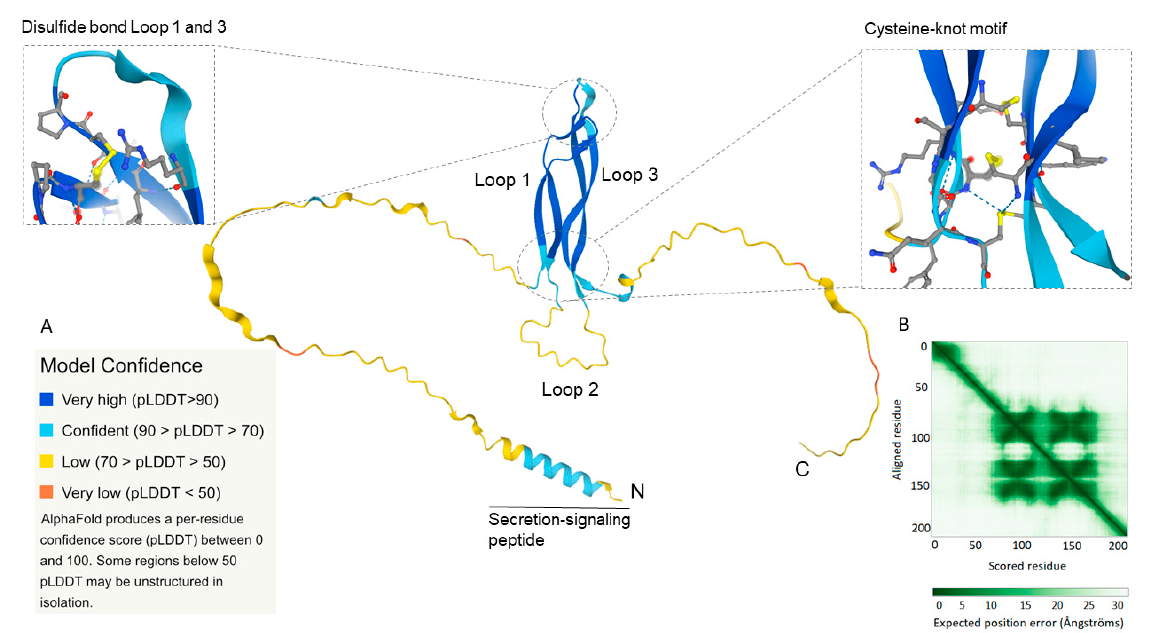
Figure 4. The three-dimensional structure of human sclerostin was generated from the amino acid sequence in the novel AlphaFold Protein Structure Database (https://alphafold.ebi.ac.uk/entry/Q9BQB4) (accessed on 19 September 2021) [58]. The protein comprises a core structure of loops 1 and 3, each having two anti-parallel running β -sheets linking with three disulfide bonds (cysteine- knot motif, magnification to the right; disulfide bond in yellow) and one disulfide bond in the top (magnification to the left; disulfide bond in yellow). Sclerostin contains also a flexible second loop in the bases and two N- and C-terminal spacer arms. ( A ) Confidence score (0–100) of model accuracy based on per-residue predicted local-distance difference test (pLDDT). Loops 1 and 3 have a high to very high confidence score (pLDDT > 70) and loop 2 and the spacer arms low confidence score (pLDDT < 70). ( B ) Expected position error, showing the possible interaction/proximity between the residues, depending on the distance between each residue (in Ångströms). Sclerostin has four closely aligned inner-sequence core domains, each containing one β